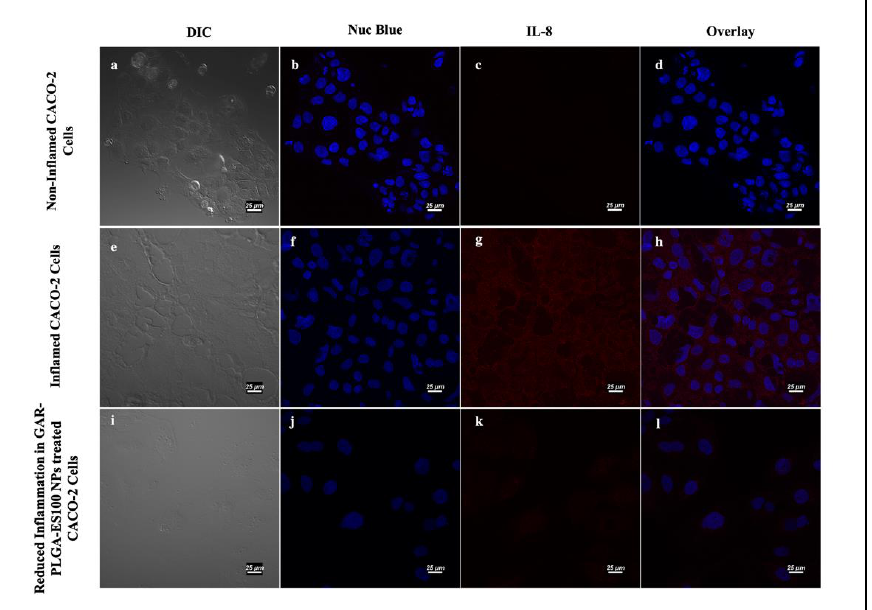
Figure 10. Induction and inhibition of inflammation in CACO-2 cells by confocal microscopy: non- inflamed CACO2 cells ( a – d ); CACO-2 cells treated with proinflammatory cocktail comprising of IL-6, TNF-α, IL-1β, and LPS at 0.4, 0.9, 1, and 30 μg/mL, respectively, for 45 min demonstrated the expression of IL-8 ( e – h ). Reduction in the expression of IL-8 in CACO-2 cells was observed after treatment with GAR-PLGA-ES100 NPs (250 μg/mL) for 48 h ( i – l ) (at scale 25μm).